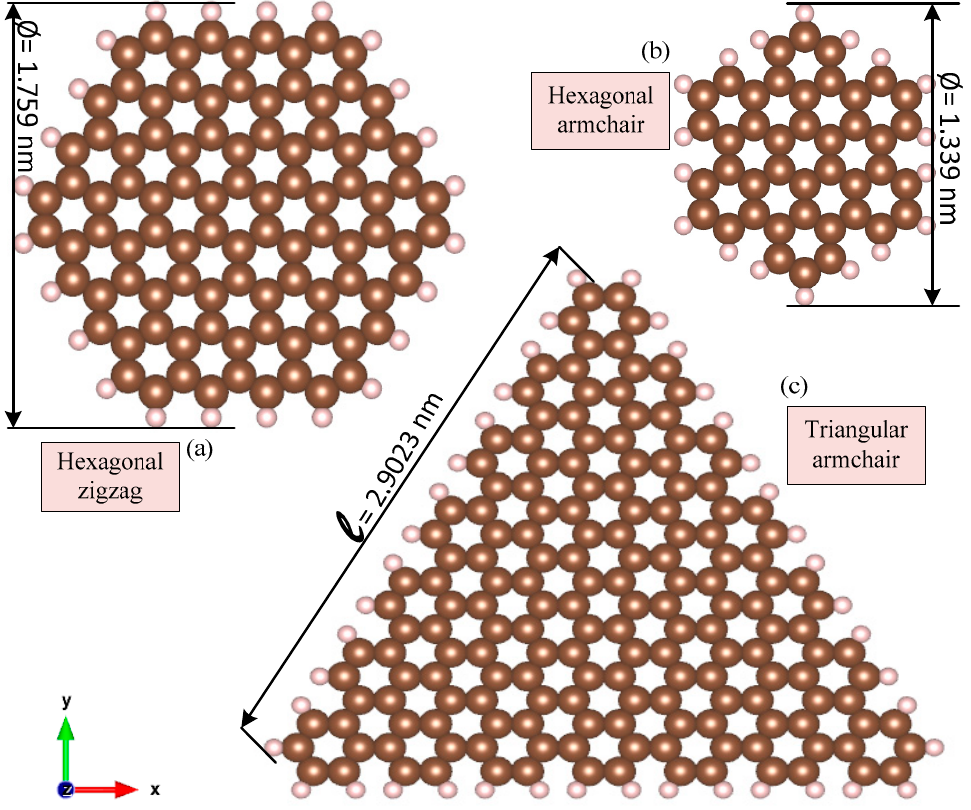
Figure 1. Schematics of the samples of monolayer graphene quantum dots (GQDs) with hydrogen-atom passivation: ( a ) hexagonal C 96 H 24 with a zigzag edge, ( b ) hexagonal C 42 H 18 with an armchair edge, and ( c ) triangular C 168 H 42 with an armchair edge.